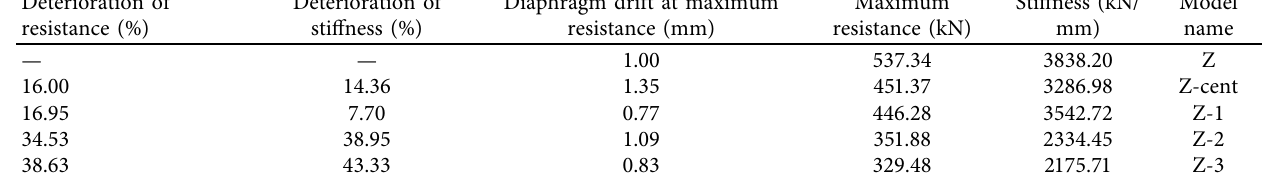
Table 6: Obtained parameters from models with opening with different layouts with loading in Z direction. Deterioration of resistance (%)